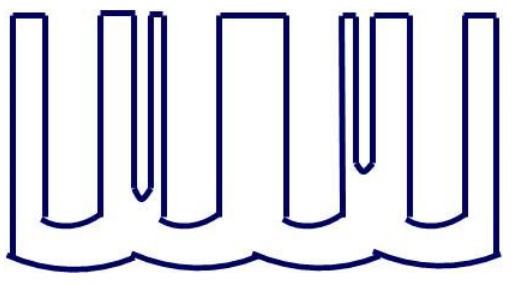
Figure 7. Schematic view of PAA with channel of different heights some of which stop after onset at the outer oxide surface in contact with the electrolyte. Additionally, the scalloped surface imprinting oxidizing aluminum is shown.